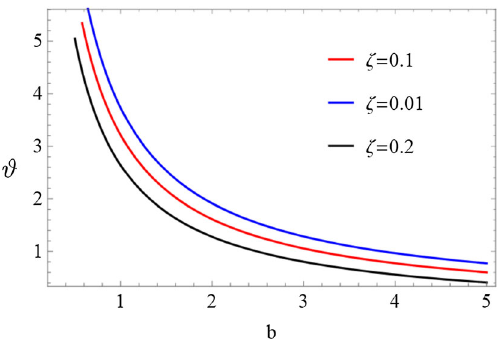
Fig. 4 Plot of deflection angle w.r.t impact parameter b for increasing valuesofthecouplingconstant ζ .Weuse Q = 0 . 3 , M = 1 , (cid:14) = 10 − 5